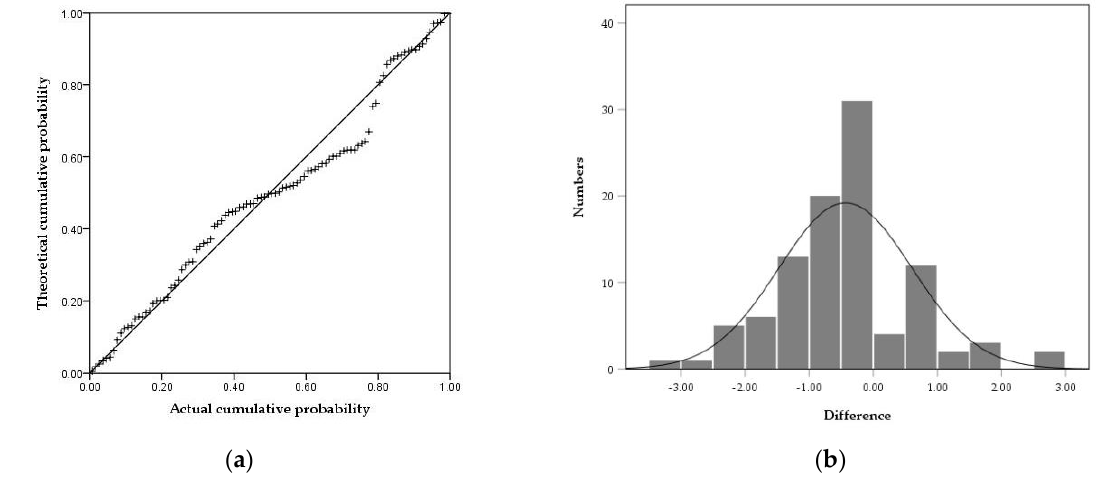
Table 3. Paired samples t -test of LA of LAI-2200C and LA-DT for 100 individual rapeseeds.